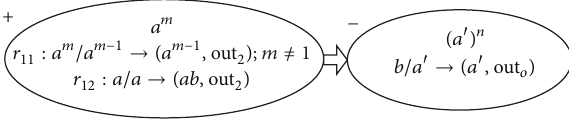
Figure 3: P chain system for subtraction.